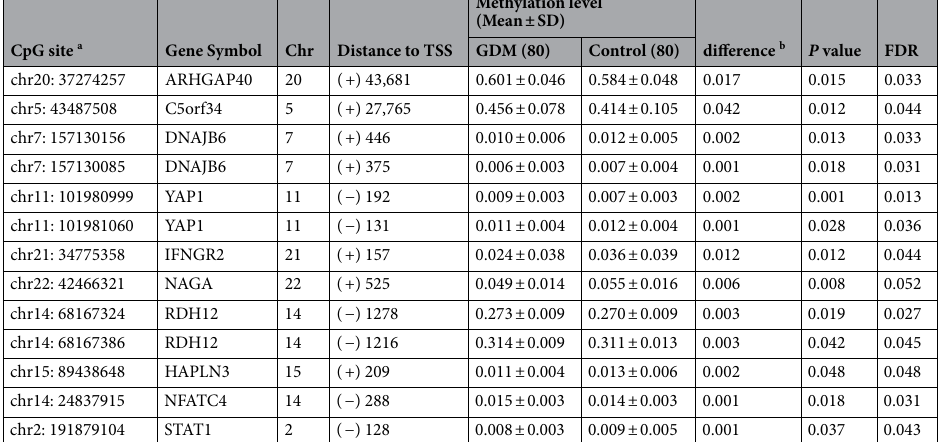
Table 2. Varying DNA methylation target CpG site and related genes. Abbreviation: Chr chromosome, TSS transcription start site and strand; CpG site a : position on chromosome; difference b : the difference of the mean methylation level in the GDM group to that in the Control